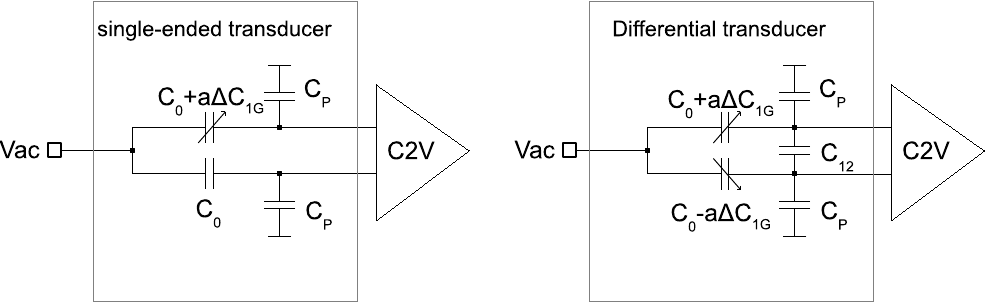
Figure 19. Generic circuits illustrating FOM calculation of single-ended ( z -axis) and differential ( x / y )